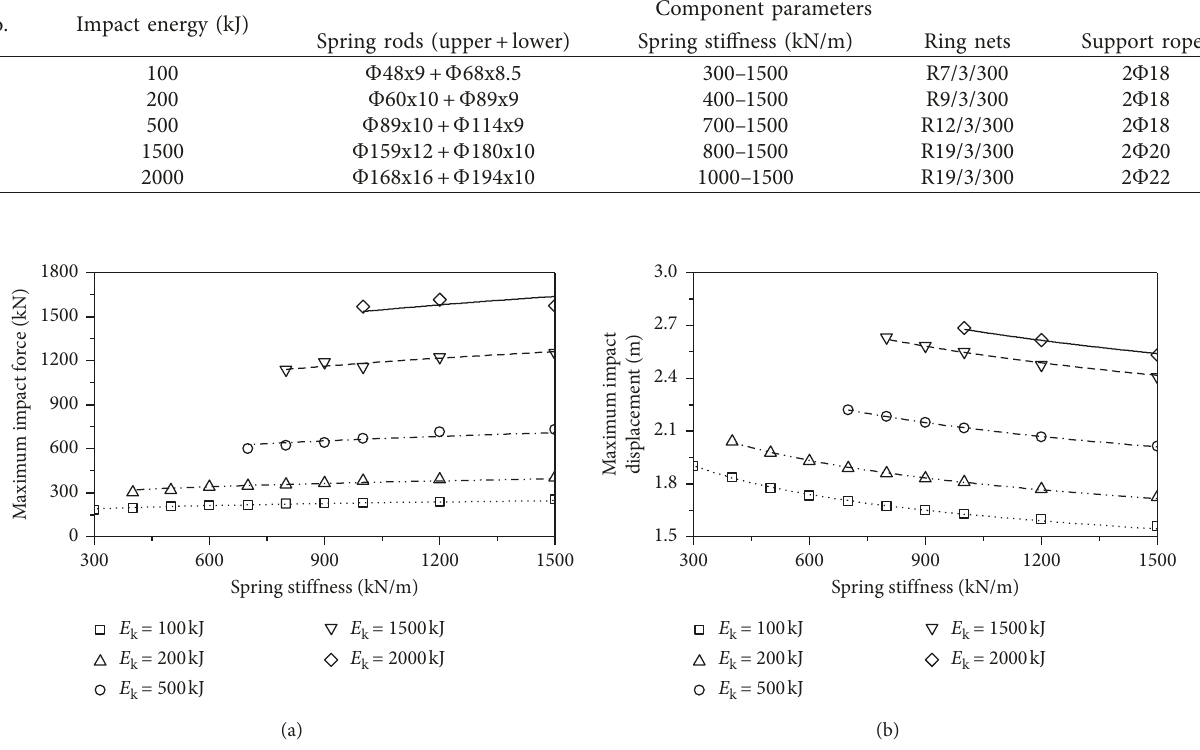
Figure 19: The simulation results and fitting curves. (a) The maximum impact force F . (b) The maximum braking distance d .